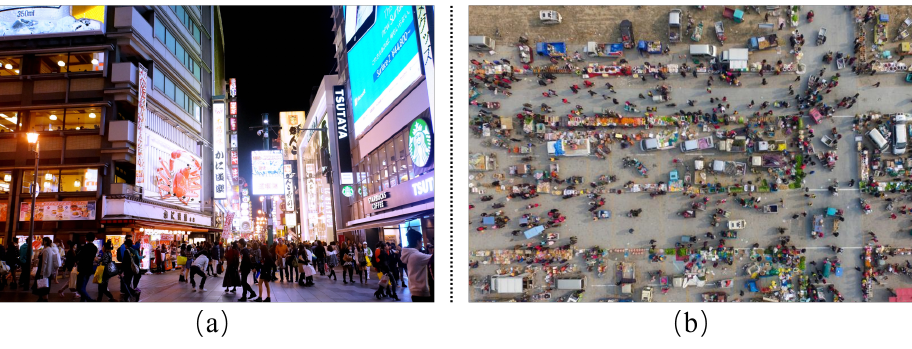
Figure 3. Comparison of target occlusion in images under different viewing angles. ( a ) There are serious occlusion problems between different people in natural images. ( b ) In images acquired by drones, due to the overhead perspective, there is almost no problem of mutual occlusion between people and vehicle